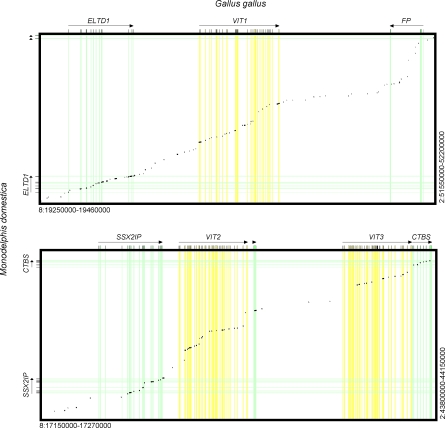
Genome Alignment (Dot Plot Representing SIM Alignments) of Opossum/Chicken Syntenic Regions VIT1-VIT3 RegionsThe chain with the best cumulative score is shown. Alignment of flanking genes confirms the synteny of the aligned regions. The subsets of alignments corresponding to VIT exons of the best chain for all three regions have significantly higher scores than genomic background hits in the chain (p < 0.05, Mann-Whitney U test). This shows that VIT1-VIT3 exon matches in opossum represent nonrandom hits and thus correspond to real coding sequence matches.